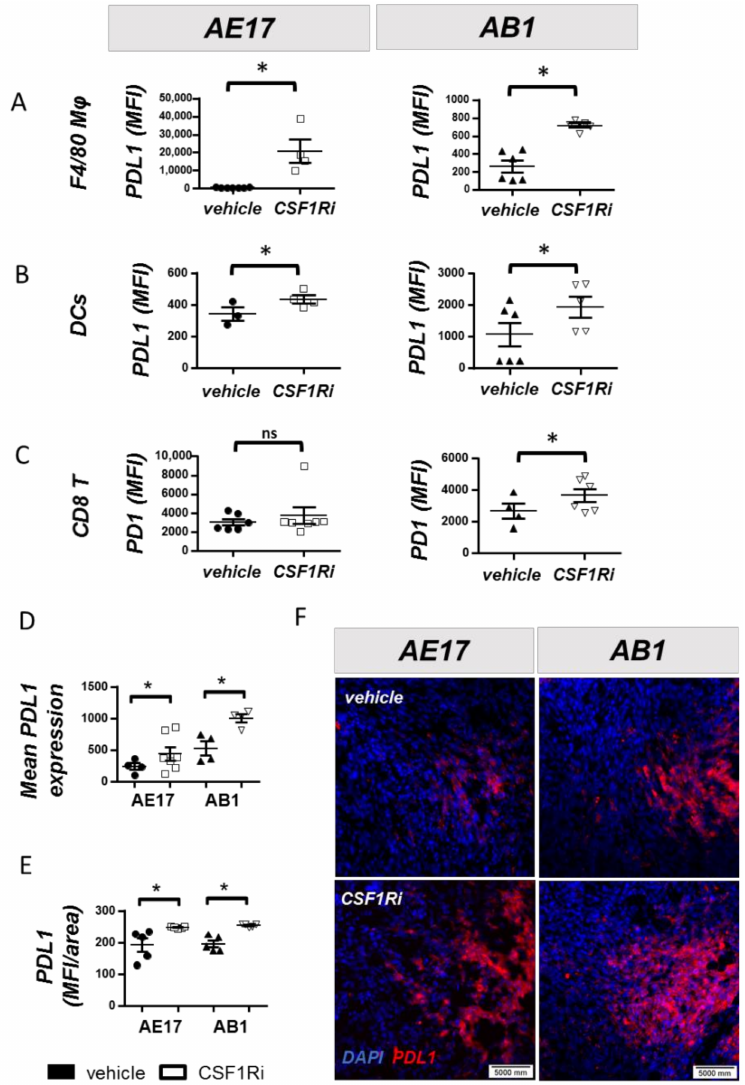
Figure 4. CSF1R blockade triggers a compensatory upregulation of the PD-1/PDL1 immunosuppres- sive axis. ( A ) TAMs, ( B ) DCs and ( C ) CD8+ lymphocytes of tumors from vehicle- or CSF1Ri-treated mice were analyzed for the expression of PDL1 or PD-1. Data are presented as mean ± SEM, n = 5–8 from two independent experiments, * p < 0.05 compared to the vehicle. ( D ) PDL1 expression by tumor (CD45-negative) cells was evaluated using flow cytometry of tumor lysates. ( E ) The overall (neoplastic and immune cell) PDL1 positivity was evaluated upon immunofluorescent staining and quantified using Fiji software. Data are presented as mean ± SEM, n = 5–8 from two independent experiments, * p < 0.05 compared to the vehicle by 2-tailed students’ t